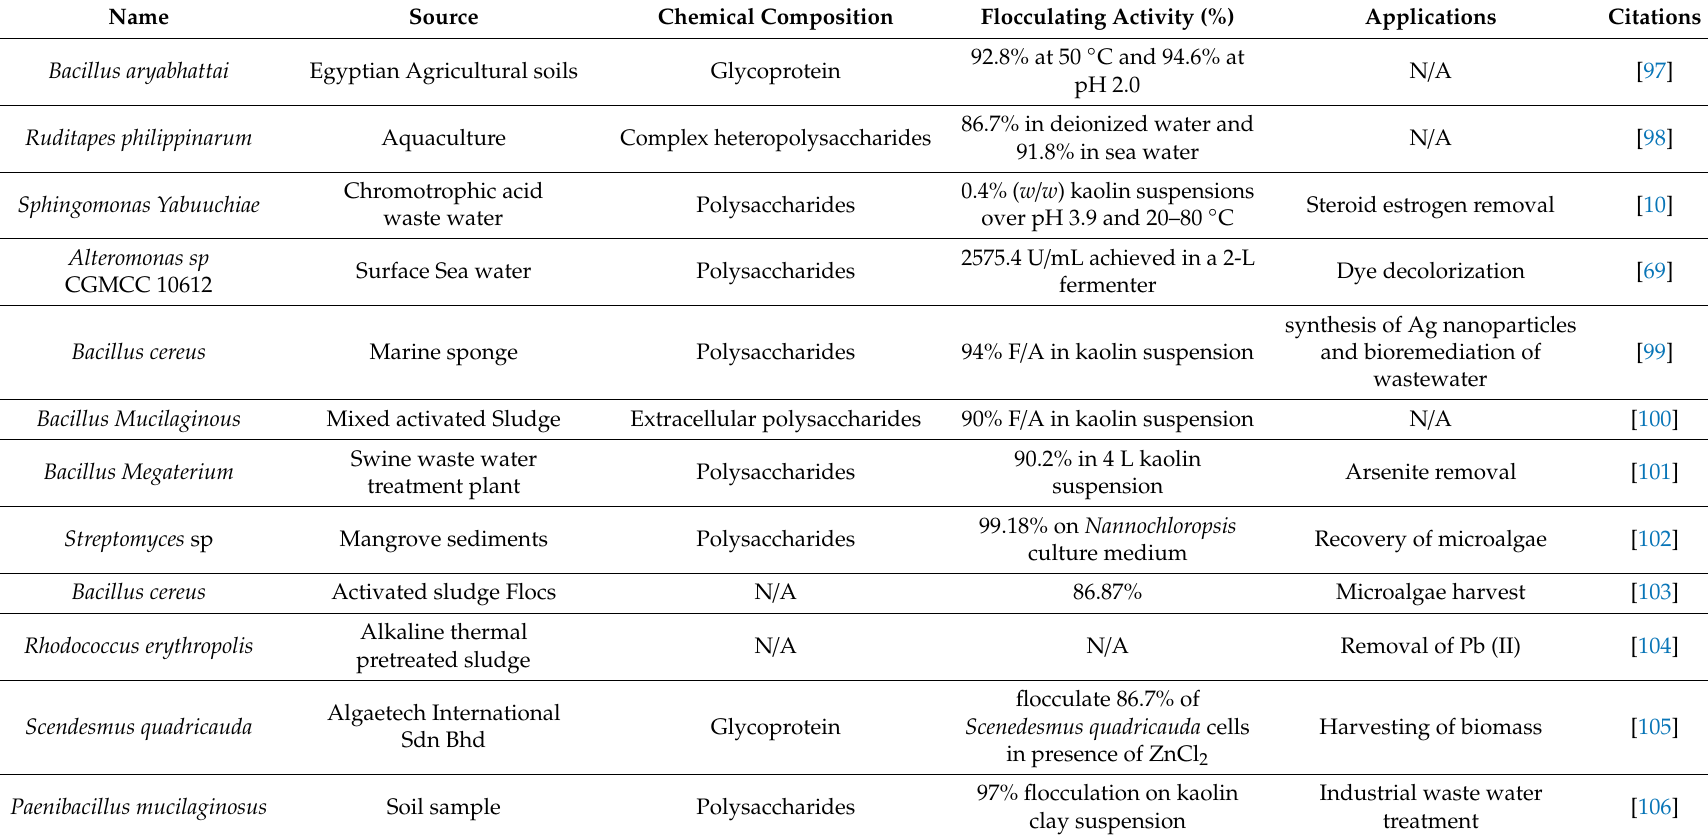
Table 4. Some of the microorganisms implicated in flocculation and their industrial